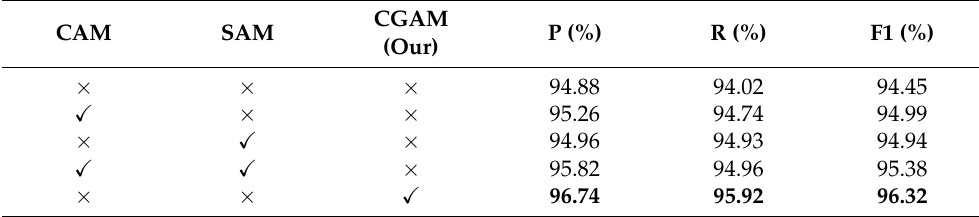
Table 5. Ablation study of attention models on RegCD-Net with our dataset. Ablations are the channel attention module (CAM), spatial attention module (SAM) and channel group attention module